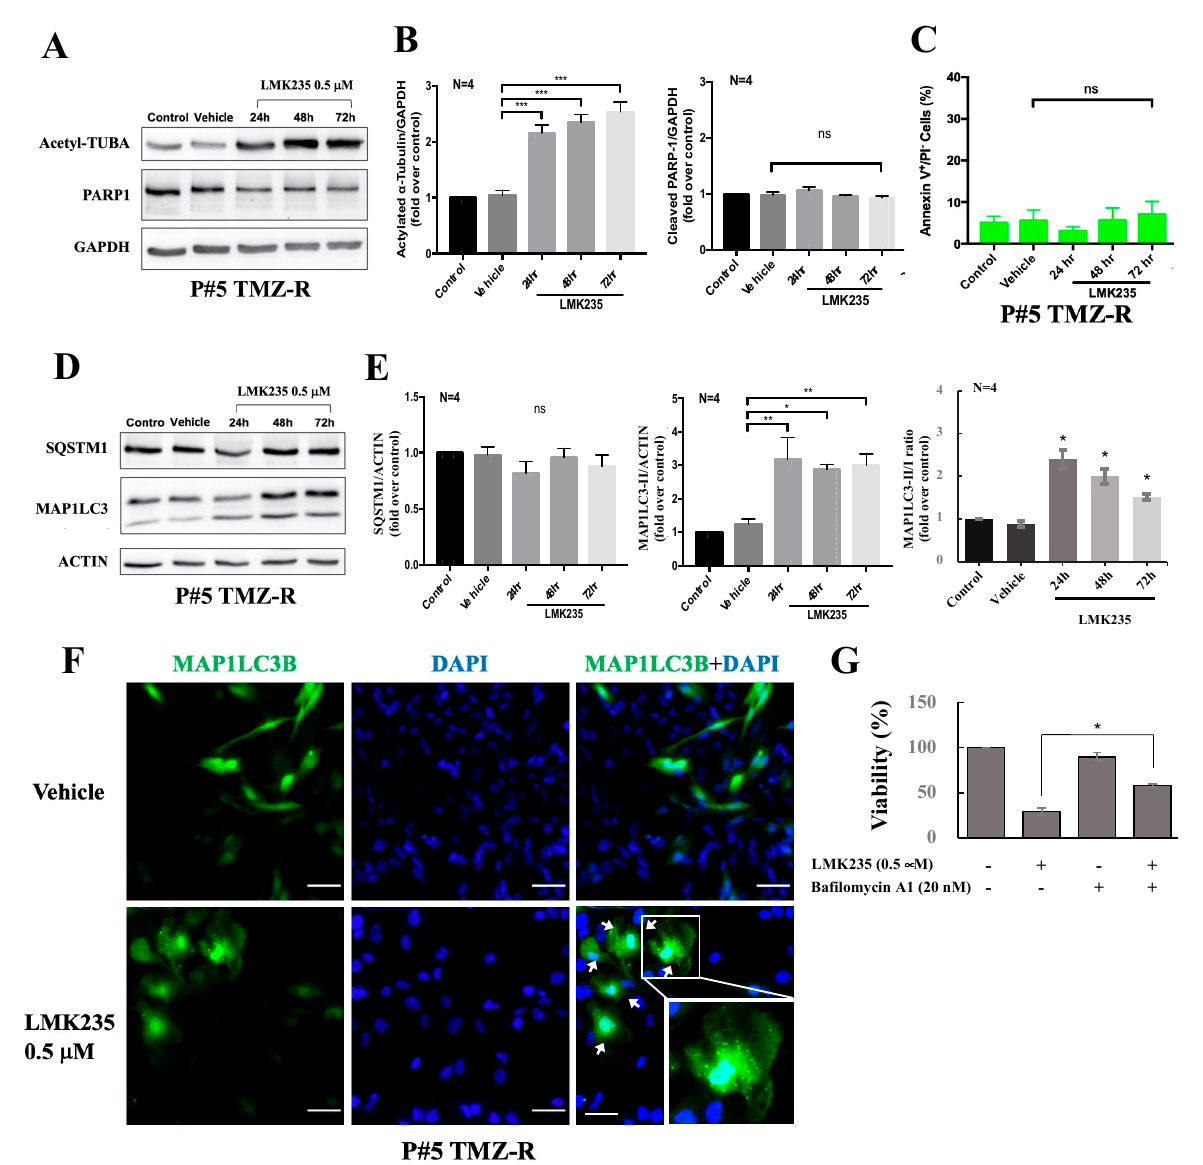
Figure 2. The effect of LMK235 on apoptosis and autophagy in GBM cells . Cells were incubated with LMK235 for the indicated doses and times. The cells were analyzed by immunoblotting against specific antibodies ( A , D ). Quantification of each band in A and D was shown in ( B , E ), respectively. ACTIN and GAPDH were used as internal controls. Annexin V staining was performed, and the percentage of apoptotic cells is shown in ( C ). ( F ) Cells were transiently transfected with MAP1LC3, treated with LMK235 for 72 h, fixed, and stained with DAPI. Cells were visualized by confocal microscopy, and images were acquired through the cy2 or DAPI channels (400 × ). The zoom-in figure was 160×. The data are representative of 5 fields/pictures of each sample. ( G ) Cells were incubated with LMK235 or bafilomycin A1 either alone or in combination at the indicated doses and then analyzed by cell viability assays. All experiments were repeated at least three times. The data are expressed as the means ± S.E. of three or more independent experiments. Scale bar = 50 µm in ( D ). ns: no significance. * p < 0.05., ** p < 0.01, *** p < 0.001. The uncropped blots are shown in File S1.